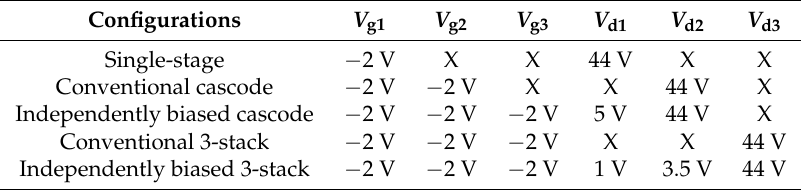
Figure 6. Reverse isolation comparison among configurations. Table 1. Bias conditions of the configurations for small-signal (SS)